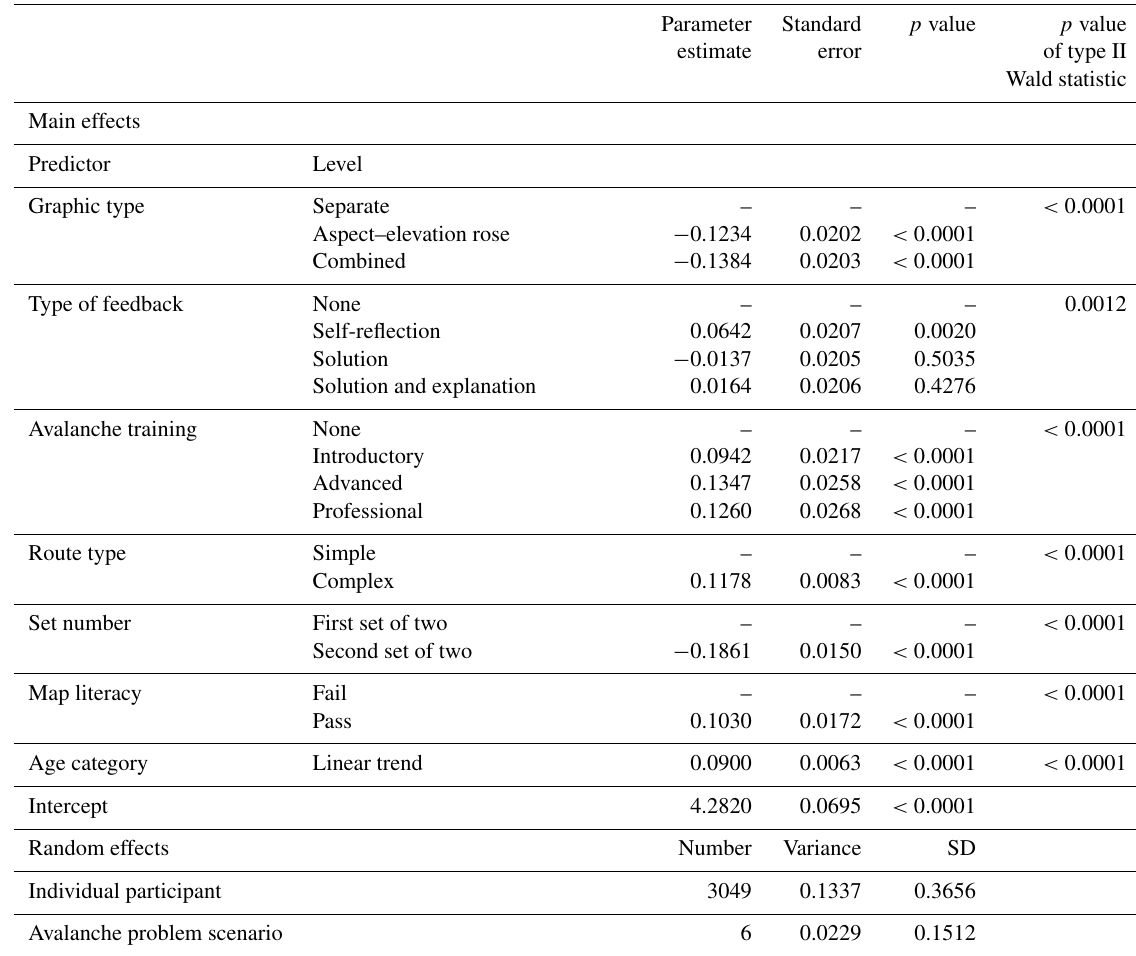
Table 2. Parameter estimates of regression model examining the participants’ completion time of the route ranking exercise. Dashes (–) indicate that the level represents the base level of the attribute, and SD stands for standard deviation. The number of observations =